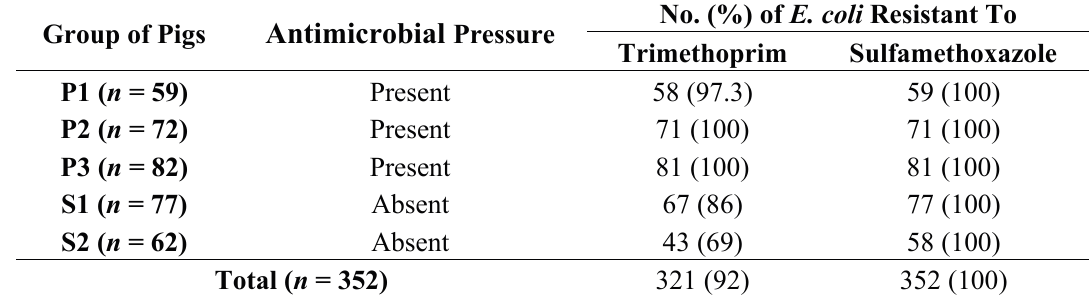
pigs during metaphylaxis (P1–P3: antimicrobial pressure present) and in post-exposure period (S1, S2: antimicrobial pressure